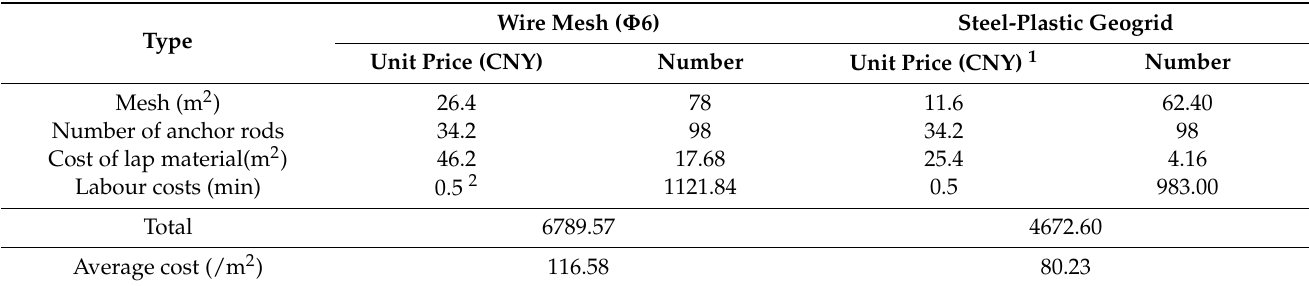
Table 7. Test section cost statistics.